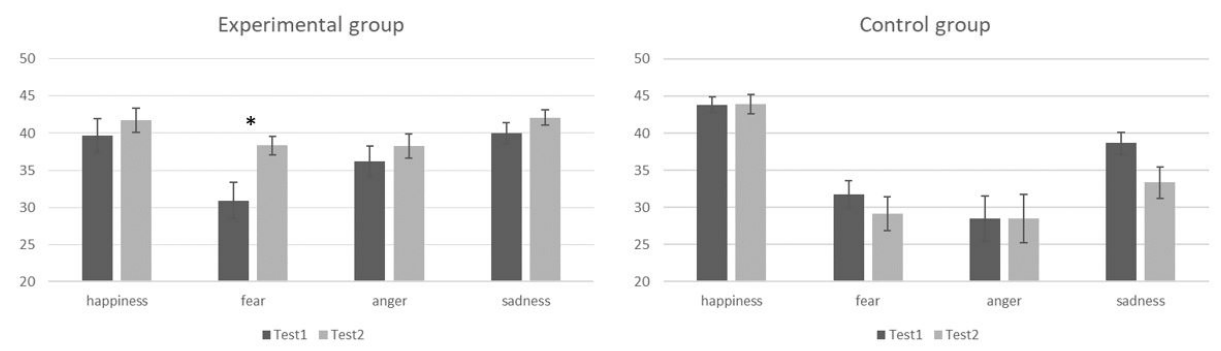
Figure 2. Mean values of responses for each emotion (happiness, fear, anger, sadness), for the experimental (leftmost panel) and control (rightmost panel) group, at Test 1 (black bars) and Test 2 (grey bars). * indicate statistically significant comparisons. Thin lines above histograms indicate standard error of the mean.